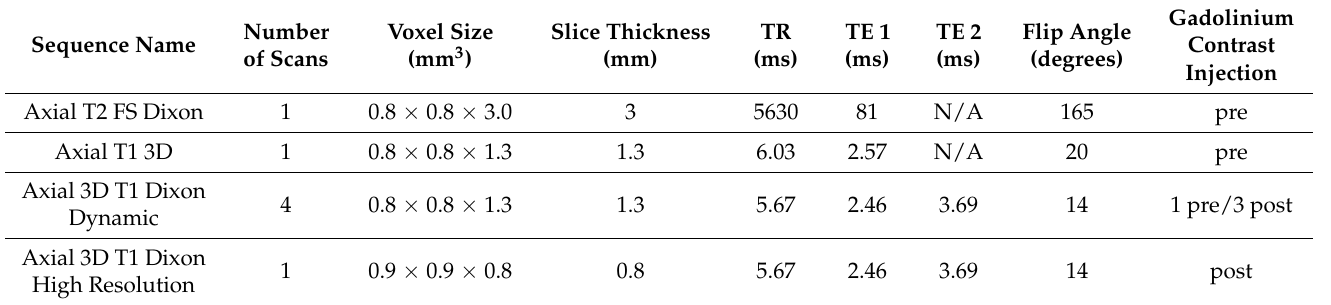
Table 3. Sequence names and parameters used for the clinical MRI study including the CE-MRI